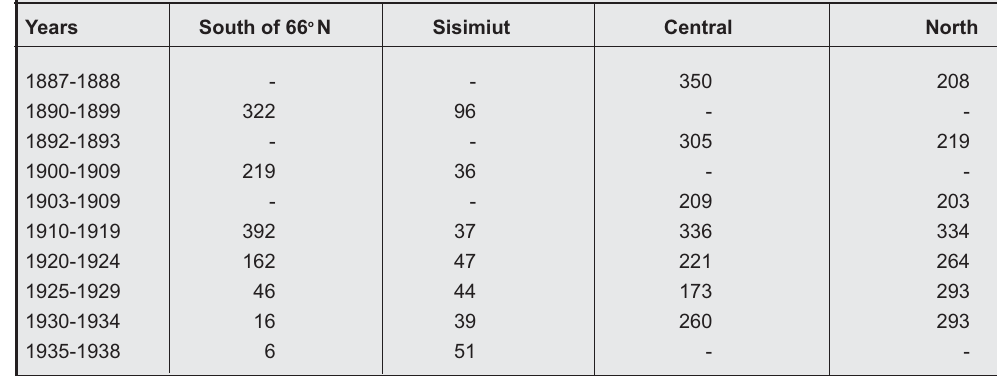
Table 4. Average catches of belugas in four areas as reported in Anon (1944). The catches are di- vided into three areas; ‘South of 66 o N’ including Qaqortoq, Paamiut, Nuuk and Maniitsoq, ‘Sisimiut’ (included in the area ‘South’ in Table 3), ‘Central’ including Disko Bay and ‘North’ in- cluding Uummannaq and Upernavik. Catches are corrected for the combined reporting of nar- whals by assuming that 100% of the catches were belugas in the areas ‘South of 66 o N’ and ‘Sisimiut’, and that 75% were belugas in the ‘Central’ and ‘North’ areas (see